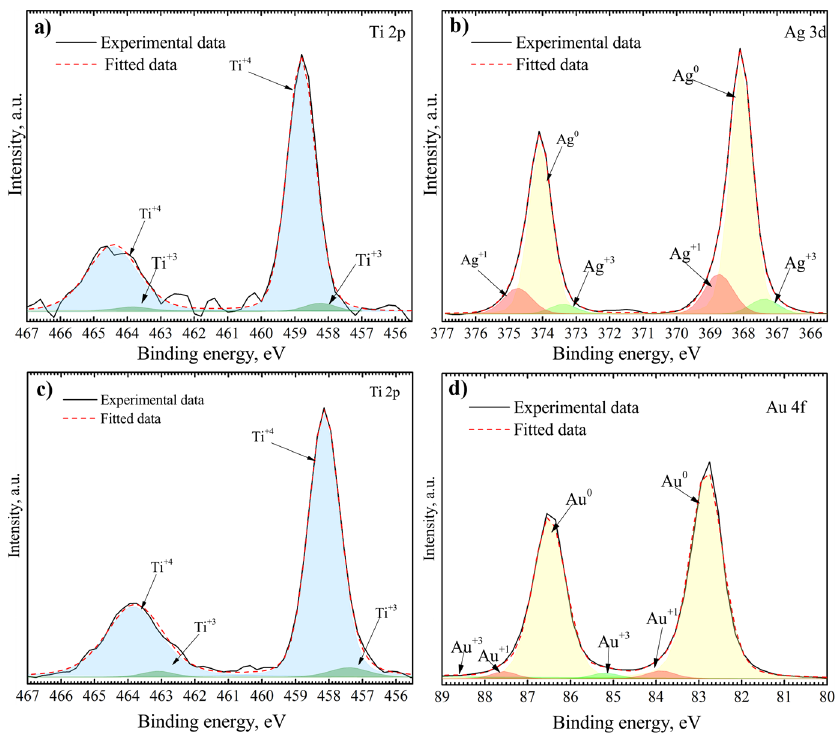
Figure 7. XPS of NP/TiO 2 system: ( a ) Ti 2p in AgNP/TiO 2 system, ( b ) Ag 3d in AgNP/TiO 2 system, ( c ) Ti 2p in AuNP/TiO 2 system, and ( d ) Au 4f in AuNP/TiO 2 system.